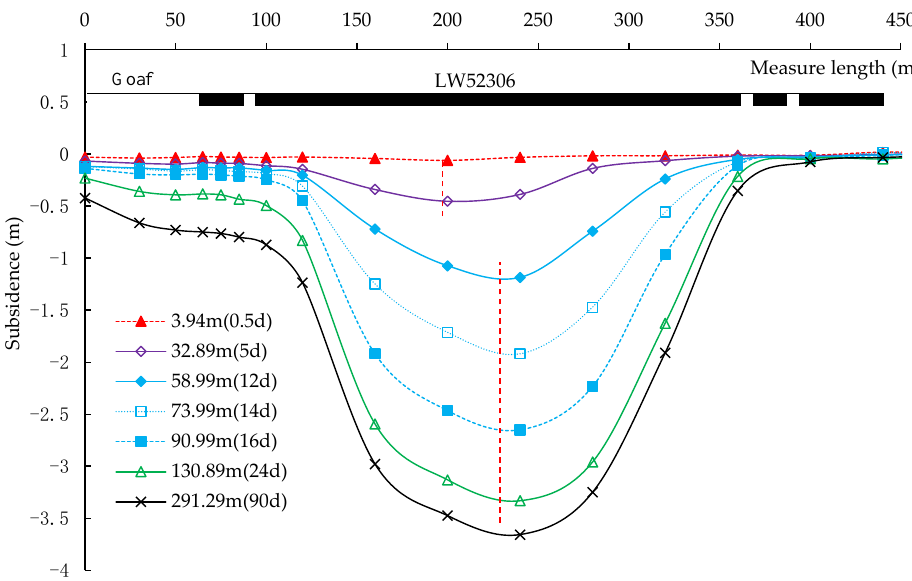
Figure 2. Surface subsidence along the transverse survey line D above the longwall panel. To compare the subsidence amount and rate between the middle (line A) and the boundary (line B) of the working face, Figure 3 presents the subsidence value and ratio of lines A and B along the distance to the longwall face. Results show that the middle of the